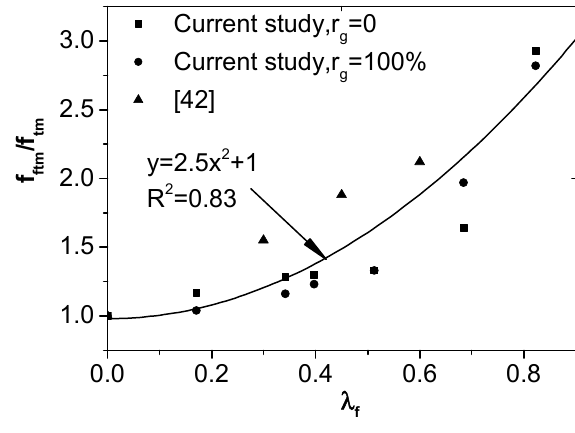
Figure 1. Relation between f ftm / f tm and λ f .